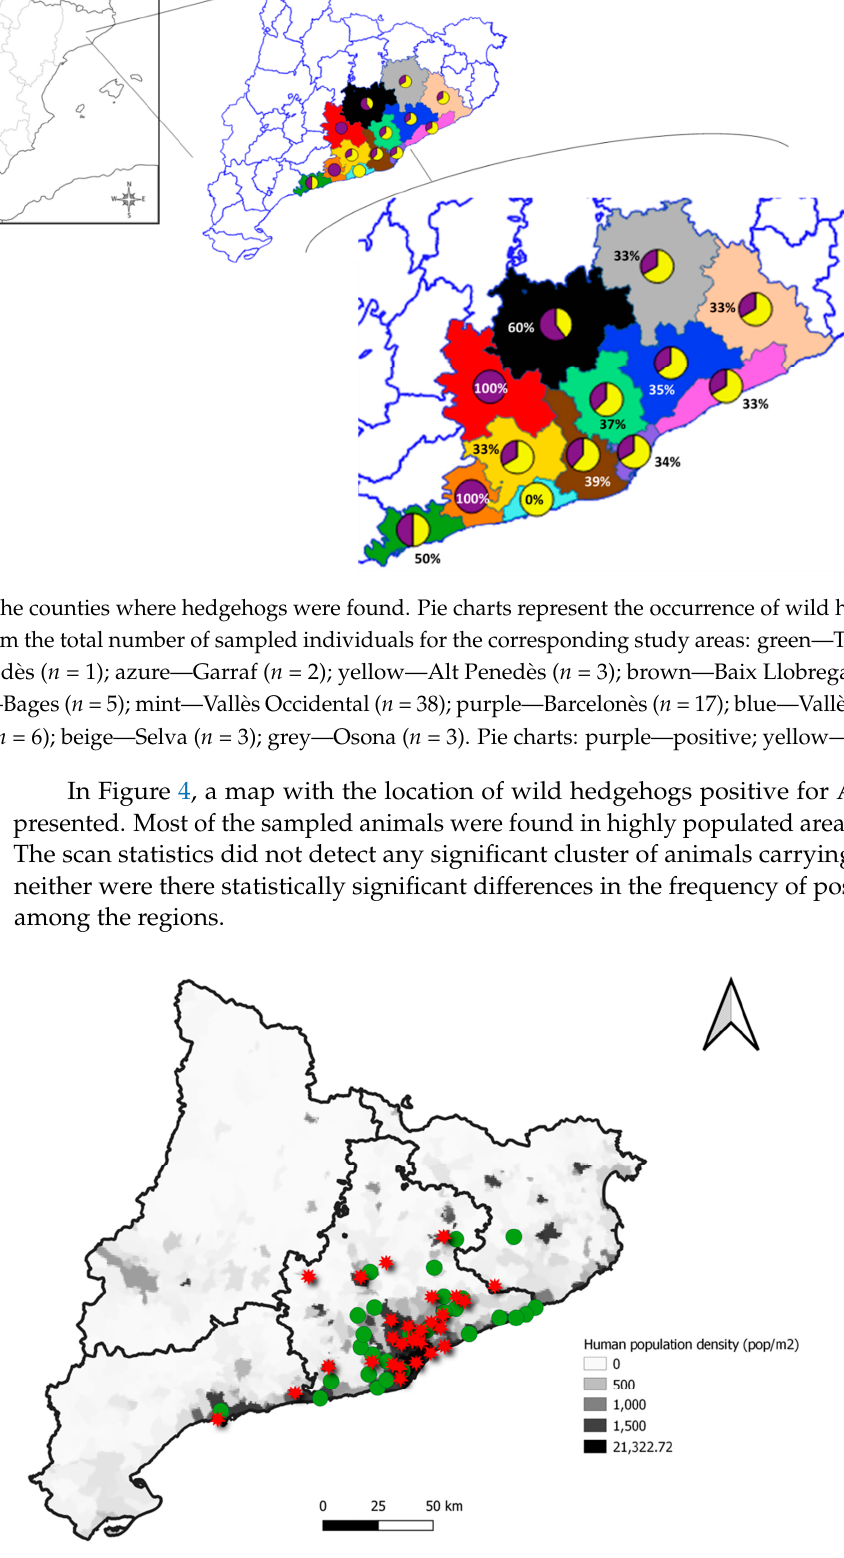
Figure 4. Localization and distribution of the hedgehogs included in the study according to the presence of at least one AMR gene (red star) or their absence (green dot) in each municipality over the human population density of each zone.